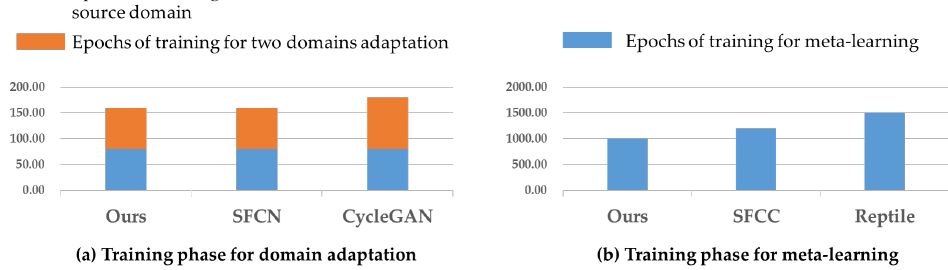
Figure 9. Comparison of Computational Cost Analysis with other methods.